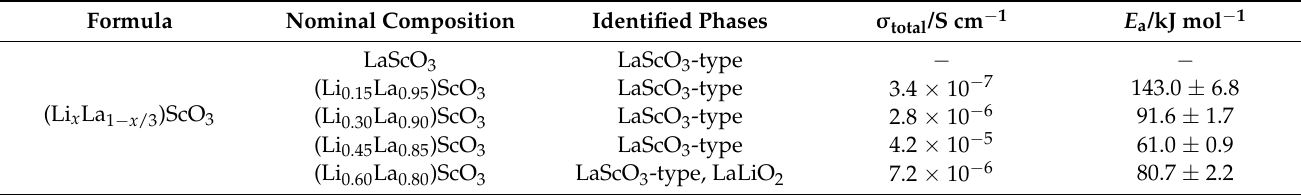
Table 1. Ionic conductivities at 623 K and activation energies of the obtained (Li x La 1 − x /3 )ScO 3 . Formula